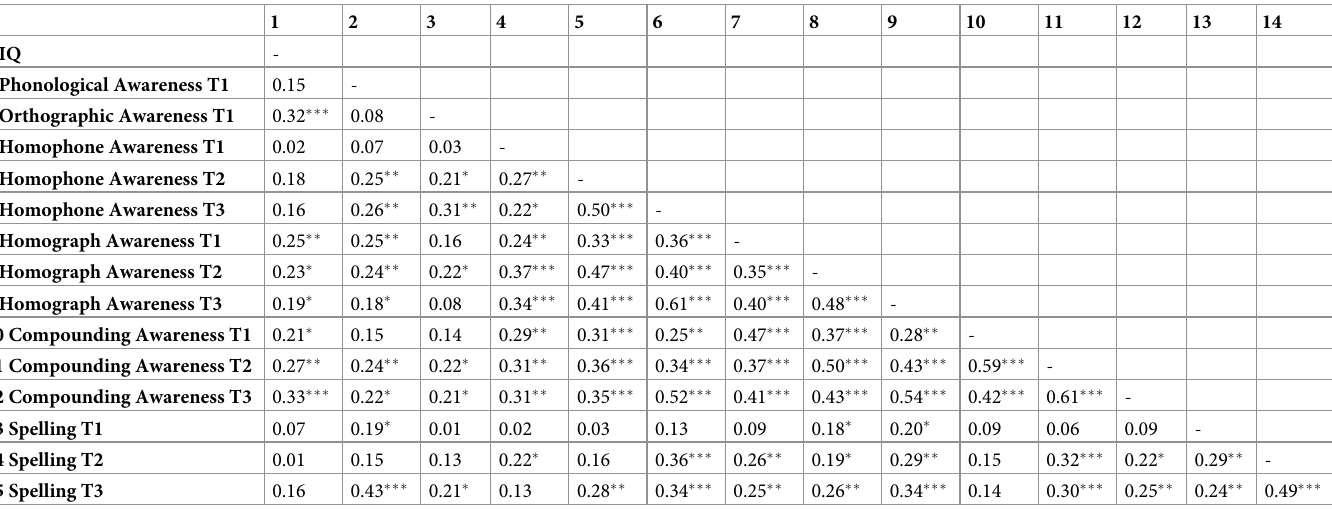
Table 2. Correlation coefficients for all